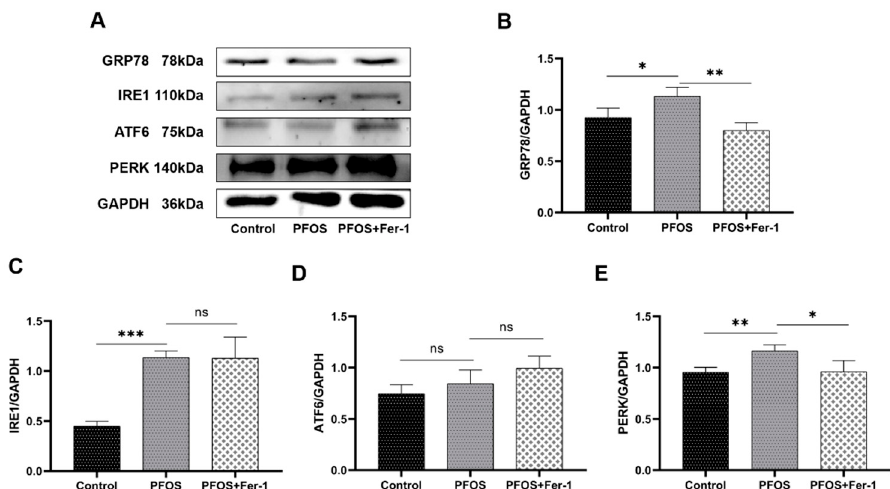
( D ) comparison of FTH1 expression among control, PFOS and PFOS+Fer ‐ 1 group cells.